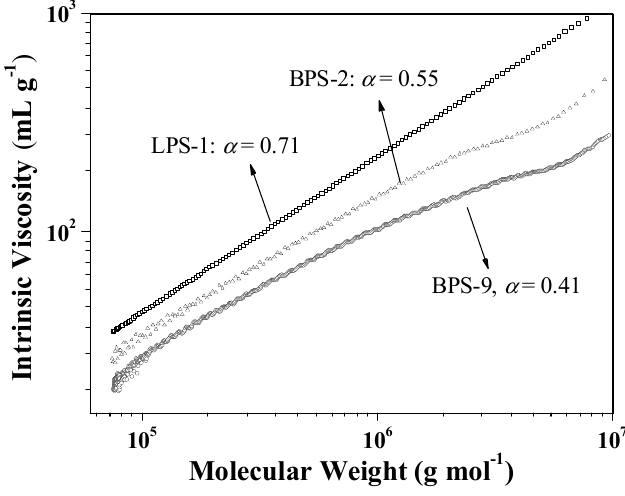
Figure 4. The Mark–Houwink plots of some typical polymers.